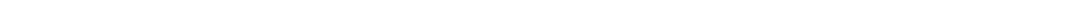
(see fi gure on previous page) Fig. 4 NAC treatment inhibited TIME signaling in Bmi-1 − / − mice more than in Bmi-1 − / − p16 − / − mice. Western blots of pulmonary extracts showing a SFTPC, collagen 1, α -SMA, mature TGF- β 1, TGF- β RII, Smad2, pSmad2 (Ser465/467), pSmad2/3 (Ser423/425); b IL-11, IL-11R α 1, MEK1/2, pMEK1/2(Ser217/221), ERK1/2, pERK1/2(Thr202/Tyr204), elF4E, p-elF4E(Ser209), RSK, and p-RSK(Ser380). c , d Protein expression relative to β -actin (graph a) was assessed by densitometric analysis. Six mice per group were used for experiments. Values are the means ± SEM of six determinations. * P < 0.05, ** P < 0.01, *** P < 0.001 compared with the WT group; # P < 0.05, ## P < 0.01, ### P < 0.001 compared with the Bmi-1 − / − group; & P < 0.05, && P < 0.01 compared with the Bmi-1 − / − p16 − / − group. e Pulmonary fi broblasts from 7-week-old WT mice treated with TGF- β 1 (5ng/ml, 48h), TGF- β 1 (5 ng/ml, 48 h) and anti-IL-11 antibody (2 μ g/ml, 48 h), IL-11 (5 ng/ml, 48 h), or IL-11 (5 ng/ml, 48 h) and the MEK inhibitor (PD98059) (10 μ M , 48 h). Representative micrographs immuno fl uorescently labeled for IL-11 and vimentin, with DAPI staining the nuclei. f Percentage of IL-11-positive areas relative to the total. g Western blots showing p16, IL-11, and collagen 1. β -actin was used as the loading control. h Protein expression relative to β -actin was assessed by densitometric analysis. Six biological replicates were used per experiment. Values are the means ± SEM of six determinations. ^ P < 0.05, ^^ P < 0.01, ^^^ P < 0.001 compared with the vehicle group; + P < 0.05, ++ P < 0.01 compared with the TGF- β 1 group; @ P < 0.05, @@ P < 0.01 compared with the TGF- β 1 and anti-IL-11 group; −− P < 0.01 compared with the IL-11